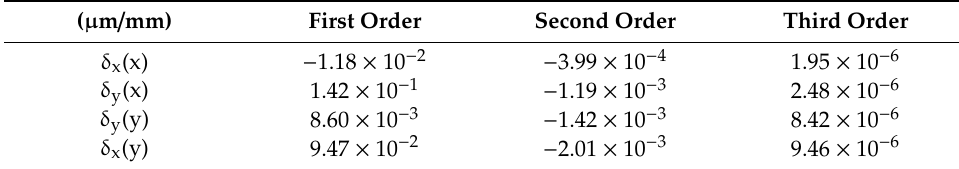
Table 3. Coe ffi cients of the translation